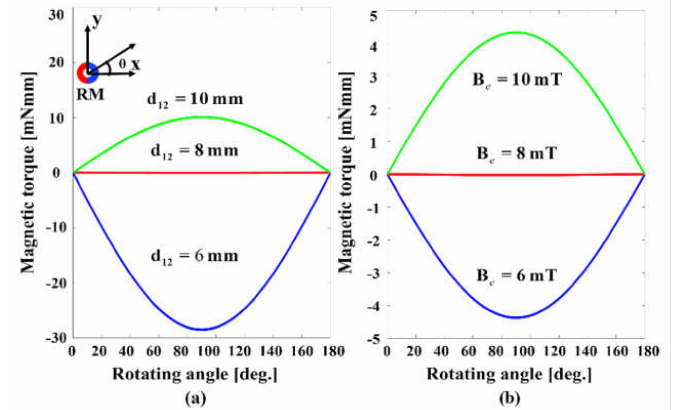
Figure 7. ( a ) The net magnetic torque on the RM for different distances between the RM and FM when the external magnetic field was 8 mT. ( b ) The net magnetic torque on the RM in different external magnetic fields when the distance between the RM and FM was 8